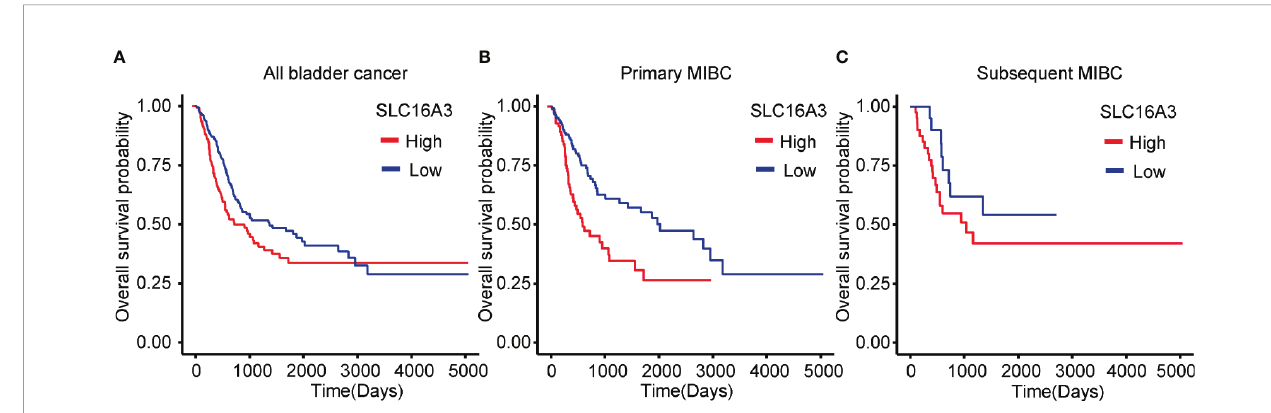
FIGURE 3 | In fl uence of SLC16A3 expression on the survival of bladder cancer patients. (A) Bladder cancer patients with high SLC16A3 mRNA expression had worse overall survival rates than those with low SLC16A3 mRNA expression (p = 0.016). (B) Primary muscle invasive bladder cancer (MIBC) patients with high SLC16A3 mRNA expression showed worse overall survival rates than those with low SLC16A3 mRNA expression (p < 0.001). (C) Subsequent MIBC patients with high SLC16A3 mRNA expression showed no signi fi cant difference from patients with low SLC16A3 mRNA expression (p =